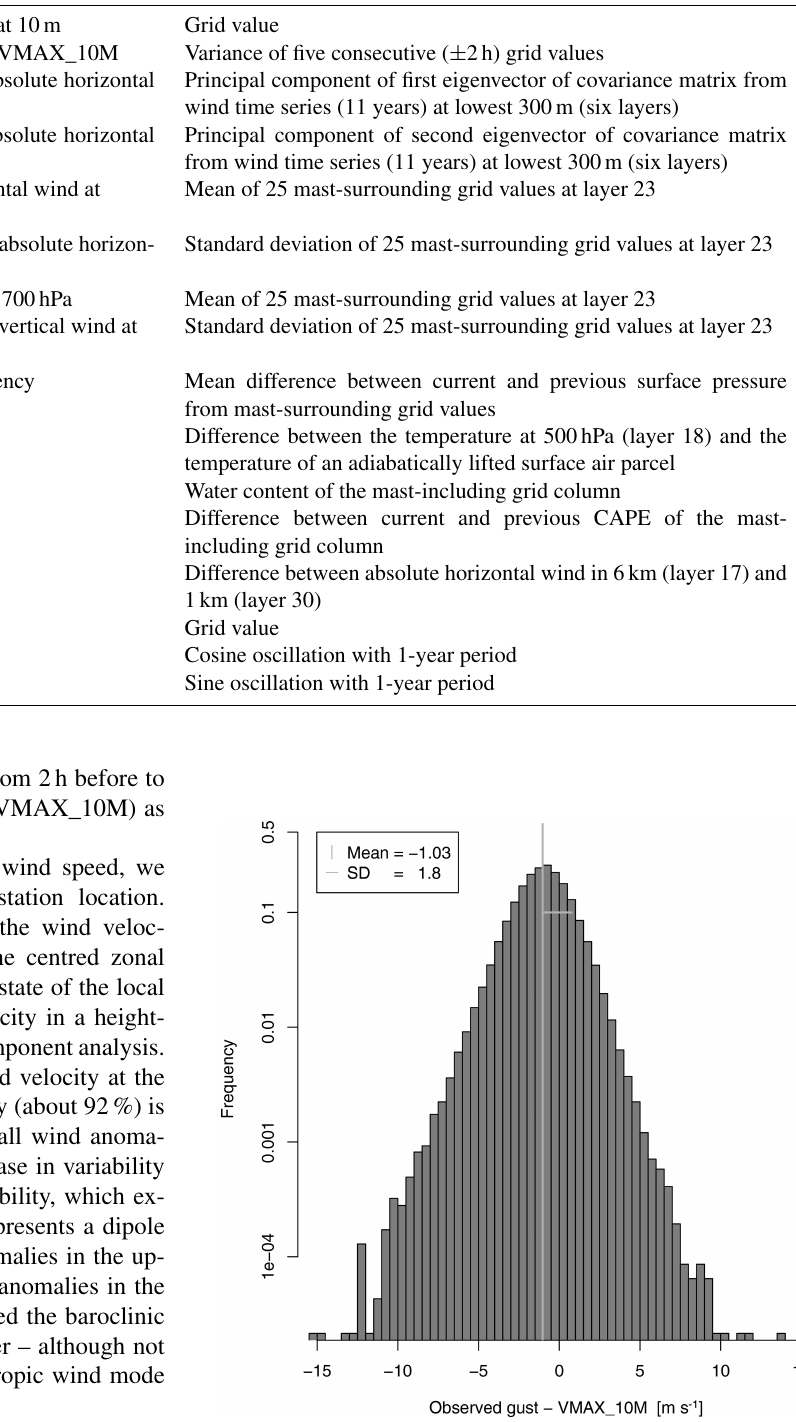
Figure 1. Histogram of differences between observed gusts at 10m and the COSMO-REA6 10m gust